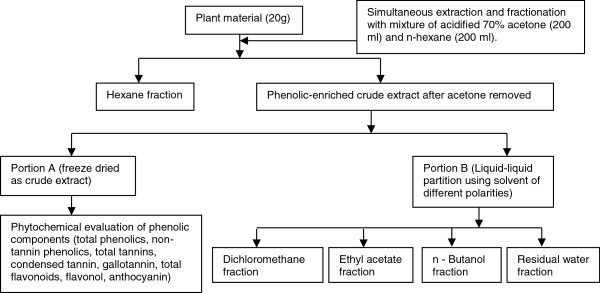
Optimized phenolic-enriched extraction process, fractionation and, analysis of the extract phenolic content.